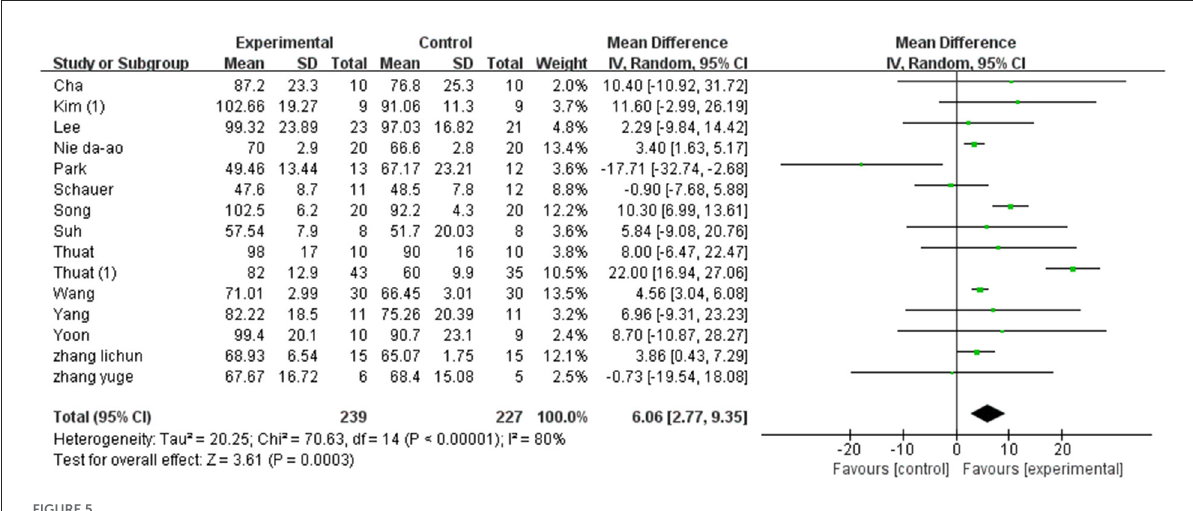
FIGURE5 Forest plot of step cadence for